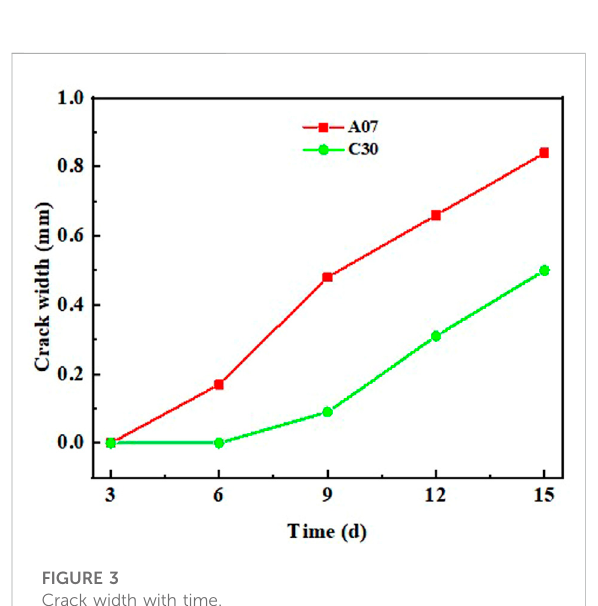
FIGURE 3 Crack width with time.